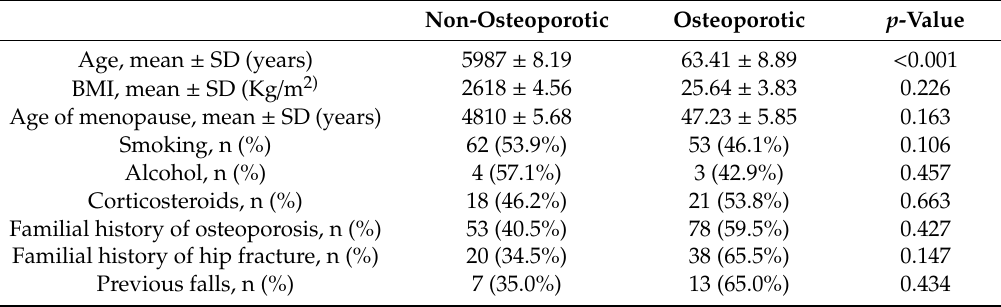
Table 1. General characteristics of the non-osteoporotic and osteoporotic subjects. Non-Osteoporotic Osteoporotic p -Value Age, mean ± SD (years) 5987 ± 8.19 63.41 ±